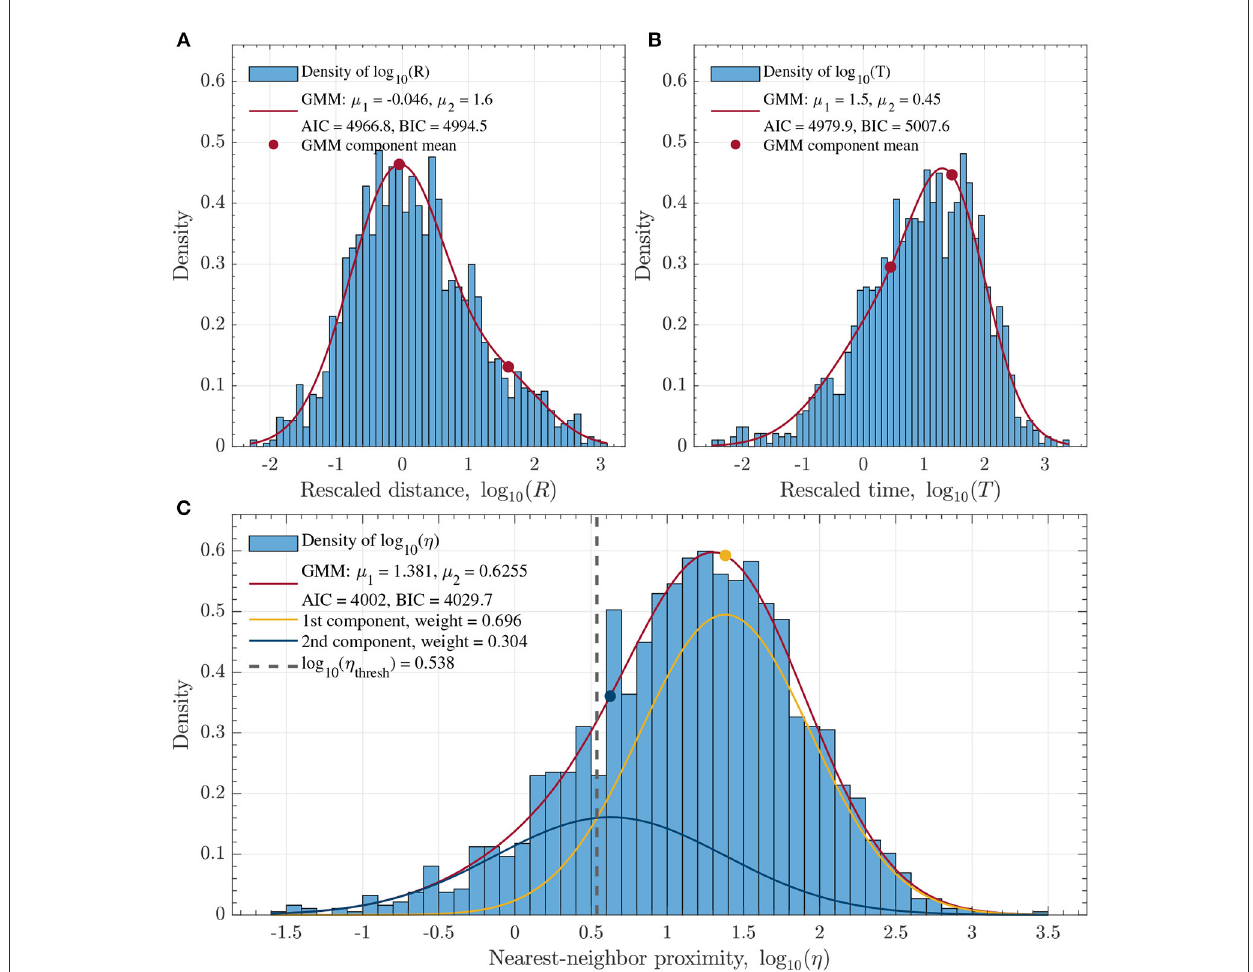
FIGURE8 The distributions of the (A) rescaled distances R , (B) rescaled times T , and (C) nearest-neighbor proximity η j for all events above magnitude m 0.94. The dark red curves are the fits of the two-component Gaussian mixture model to each distribution. The individual components are ≥ − shown in (C) as yellow and blue solid curves with the corresponding means and weights given in the legend. The threshold log 10 ( η thresh ) estimated from the intersection of the two components and is shown as a vertical dashed